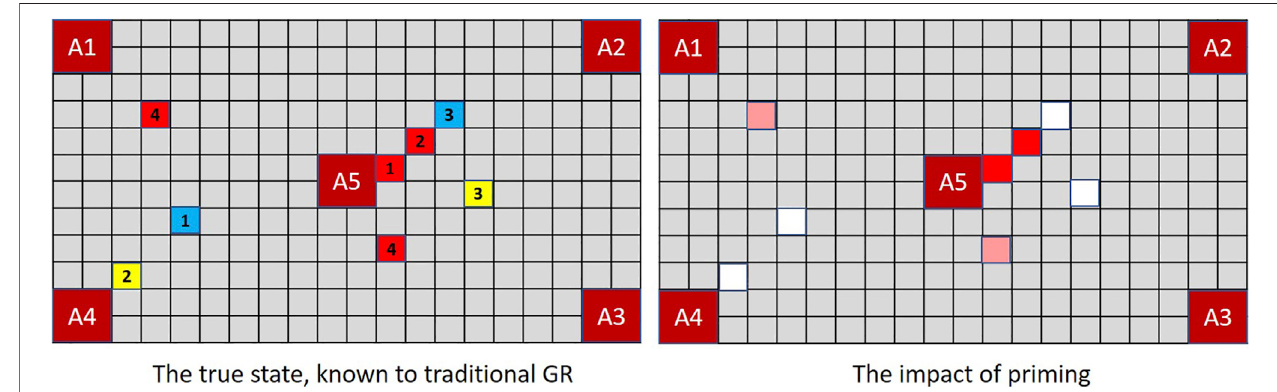
FIGURE 9 | A deceptive Player A, programmed to exploit a human or extended GR system ’ s con fi rmation bias, plays its fi rst two red tokens on an optimal path linking ( A 2, A 5). Combined with the impacts of misremembered and forgotten tokens, Player B now assesses the probability of ( A 2, A 5) signi fi cantly higher than that of ( A 1, A 4), with cost differences of − 3 and 0 respectively. When probabilities are reassessed after Player A ’ s next turn, the differential will be hard to